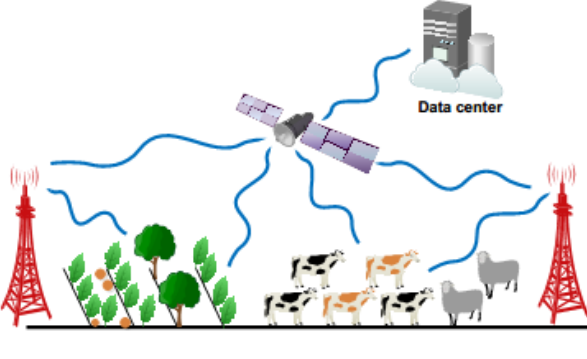
Figure 12. Application of IoT in crop production and livestock value